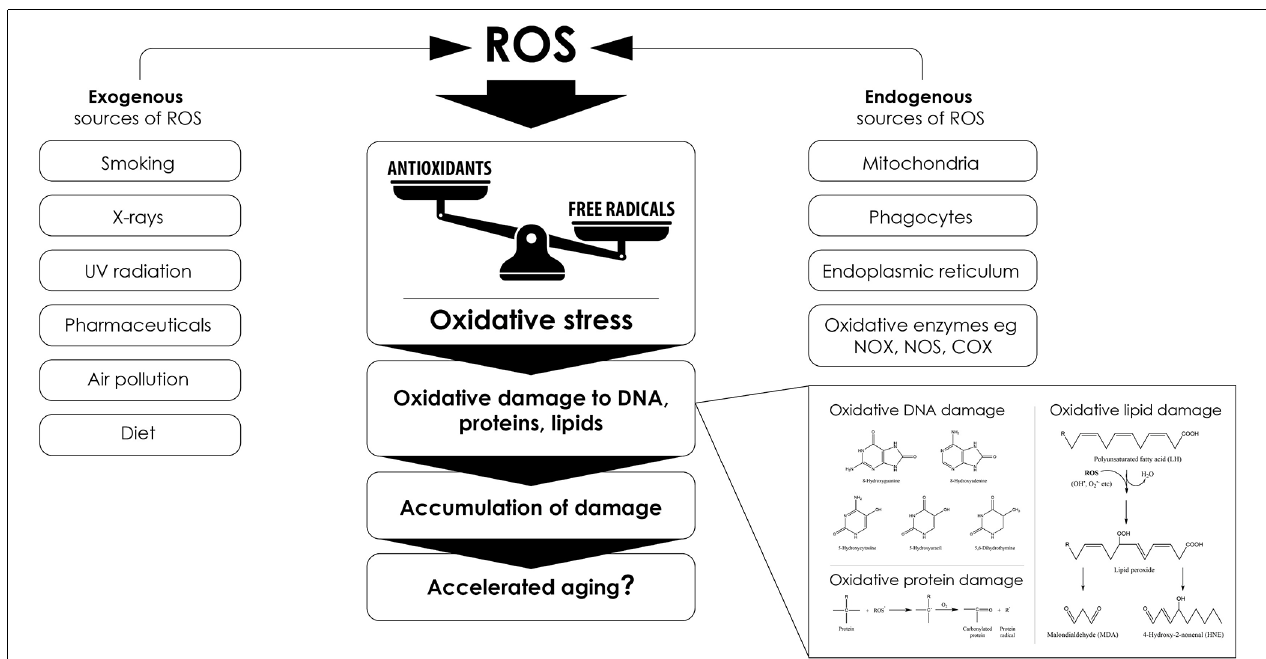
FIGURE 3 | Sources of reactive oxygen species (ROS) that lead to oxidative stress and promote aging. Several endogenous and exogenous factors contribute to excess ROS formation. Any imbalance between the production of free radicals and ROS and their elimination by antioxidant systems can cause oxidative stress